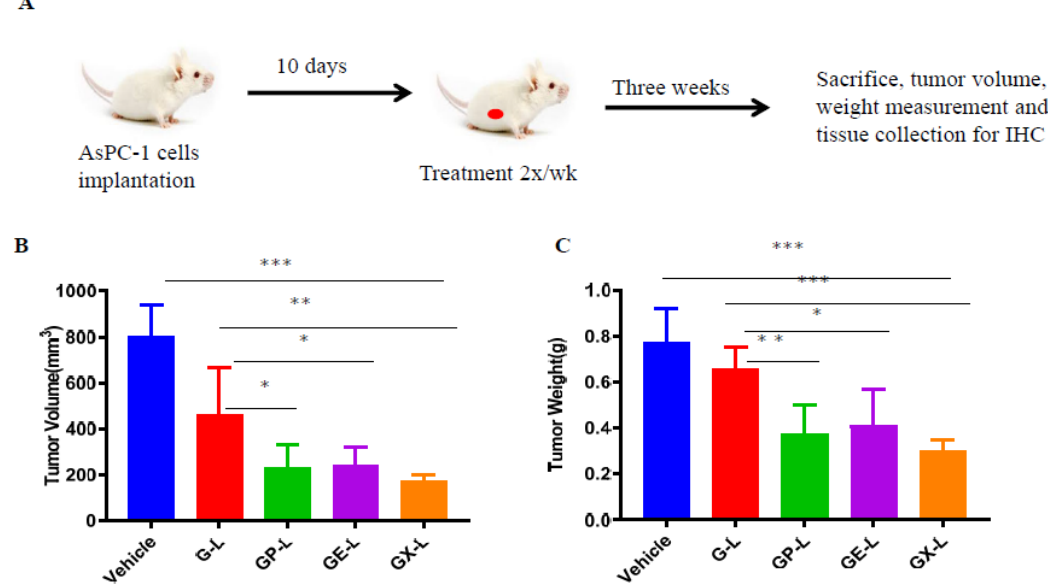
Figure 5. In vivo therapeutic efficacy of drug-loaded liposomes in an orthotopic pancreatic tumor model. Briefly, 1 × 10 6 AsPC-1 cells were orthotopically injected into the head of the pancreases of 6–8 weeks old female mice. After 10 days of cells implantation, mice were imaged by using IVIS and randomized into five groups ( n = 5 in each group). Then, mice were treated with indicated groups 2 × / week for 3 weeks. ( A ) The graphical representation of in vivo experimental plan. After the end of the treatment, mice were sacrificed, and endpoint tumor volume ( B ) and tumor weight ( C ) were measured. *** denotes p < 0.001 compared to control; ** denotes p < 0.01 compared to G-L group; and * denotes p < 0.05 compared to G-L group. (Abbreviations: G-L represents liposomal gemcitabine; GP-L represents liposome loaded with both gemcitabine and paclitaxel; GE-L represents liposome loaded with both gemcitabine and erlotinib, GX-L represents liposome loaded with both gemcitabine and XL-184).